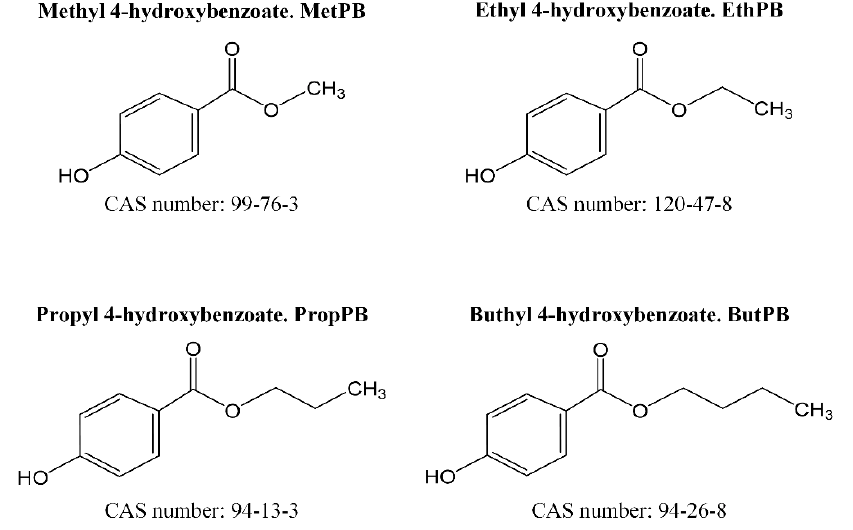
Figure 1. Parabens analysed in the present work.